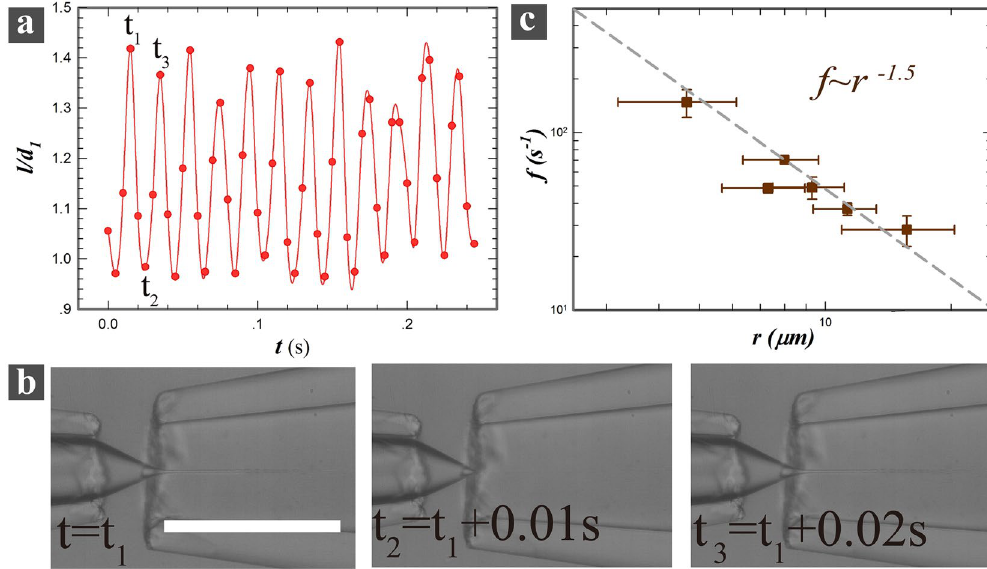
Figure 5. ( a ) A plot of the length of the water tip against time under a constant applied voltage in the high- frequency pulsating regime. The analyzed images are extracted every 2 frames from a high-speed video recorded at 1000 fps; ( b ) Representative images corresponds to a cycle of pulsation at a frequency of 50 Hz. The scale bar is 500 µ m; ( c ) The dependence of pulsating frequency f on the emitted jet size, r , indicating a power-law fit with an exponent of −